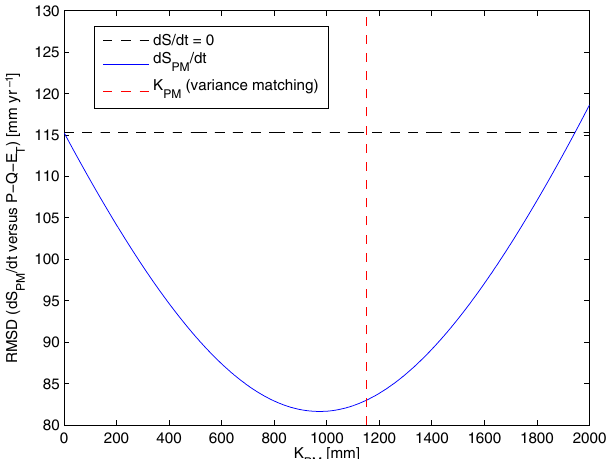
Figure 7. Relationship between annual P − Q − E T (closed over the 9-year time series) and the microwave-based d S PM / d t proxy within each of the 16 medium-scale basins listed in Table 1. The blue line is a one-to-one line and red line is the least-squares linear